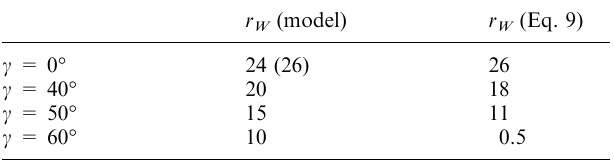
Table 5. Values of x j tan c = f j for di(cid:128)erent values of c considered in the numerical experiments. The Coriolis parameter, f , was calculated at the respective h c (given in Table 3). The intraseasonal frequency is x (cid:136) 1 : 2 (cid:2) 10 (cid:255) 6 s (cid:255) 1